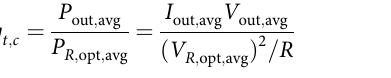
mentary Fig. 16 shows the current-time curve on 0.01 M Ω load. Figure 4c gives the average current density and corresponding average voltage on different loads under the constant output.